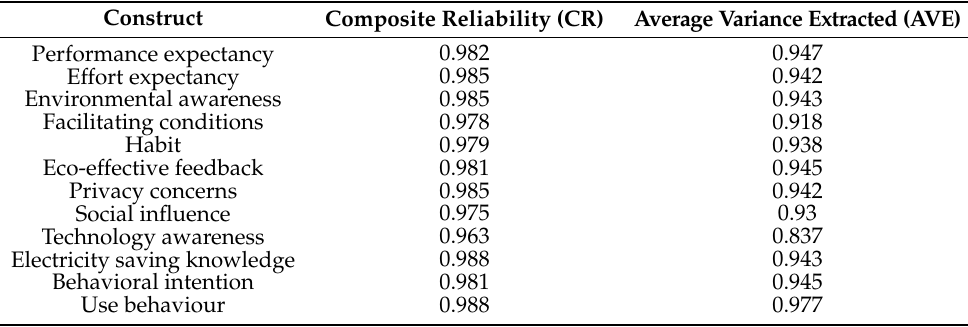
Figure 4. Measurement model. Table 3. Results of PLS Analysis: Measurement